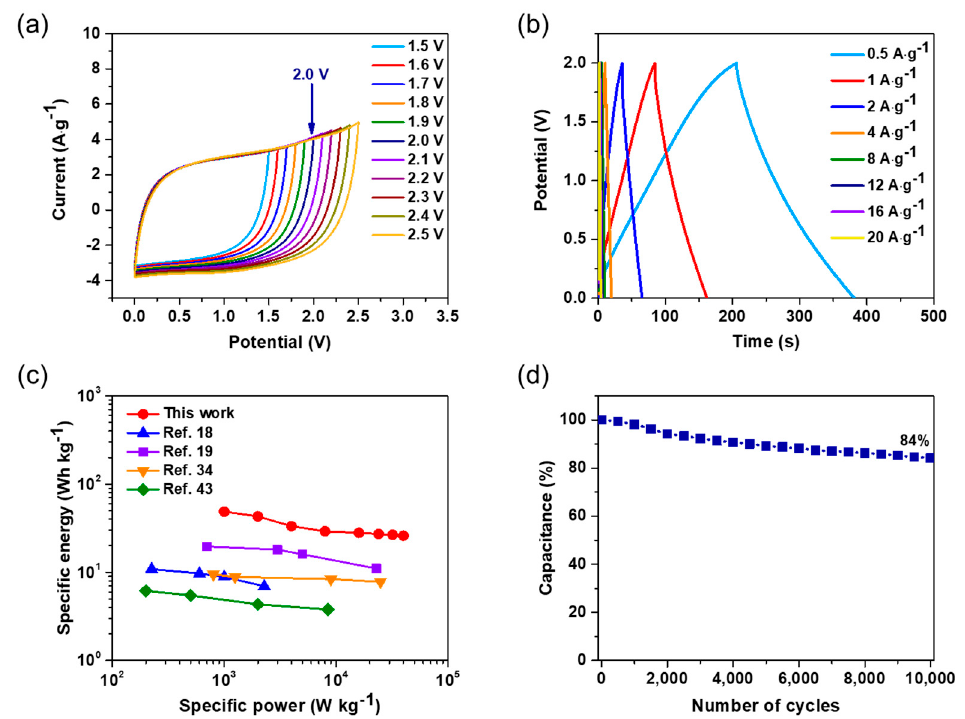
Figure 6. ( a ) CVs of the symmetric supercapacitor in two-electrode system with varying potential 1.5–2.5 V at a scan rate of 500 mV · s − 1 ; ( b ) GCD curves with varying current densities from 0.5 to 20 A·g − 1 ; ( c ) Ragone plot showing the comparison of our work with other MOF-derived nanoporous carbon based symmetric supercapacitors; ( d ) Cycle stability performance for the capacitance retention of WNPC symmetric supercapacitor.